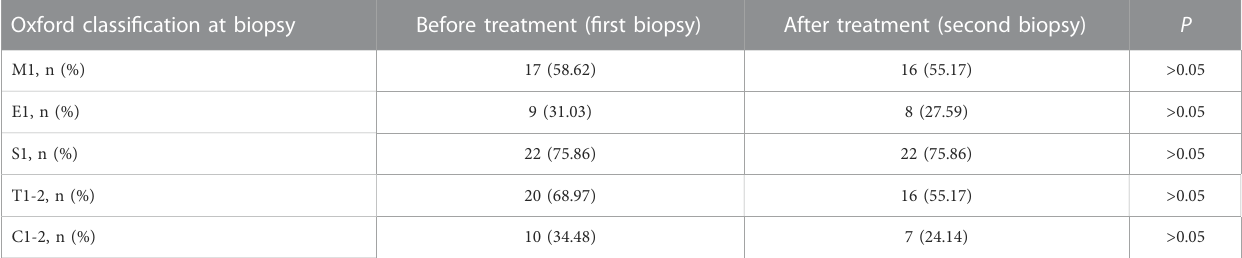
TABLE 3 Oxford classi fi cation of IgA nephropathy patients with isolated hematuria who underwent repeat biopsies ( n = 29). Oxford classi fi cation at